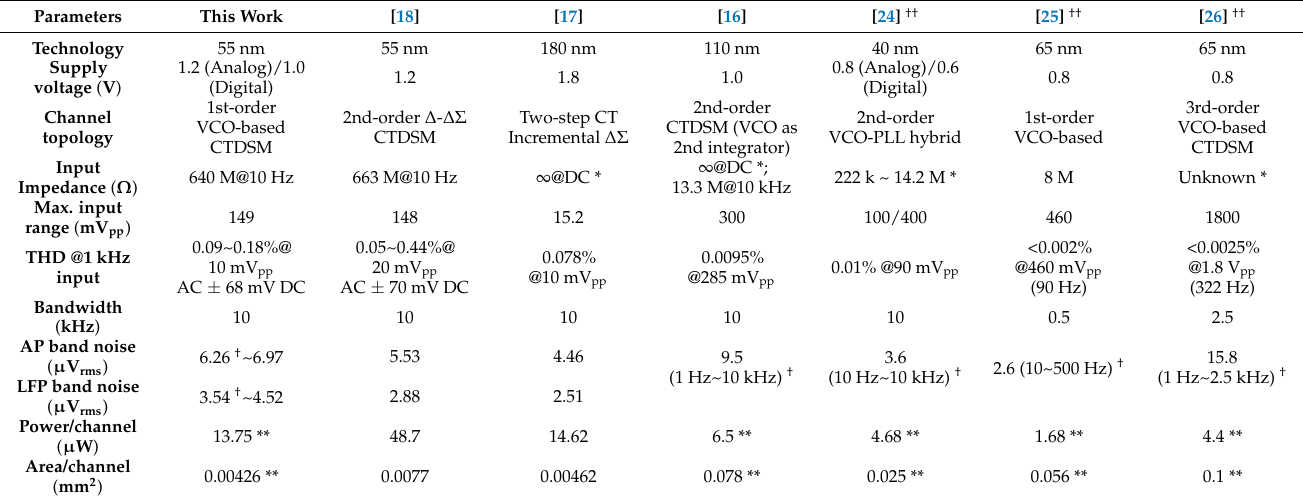
Table 2. Comparison with state-of-the-art direct-digitization neural-recording (AP and LFP) architec- tures and VCO